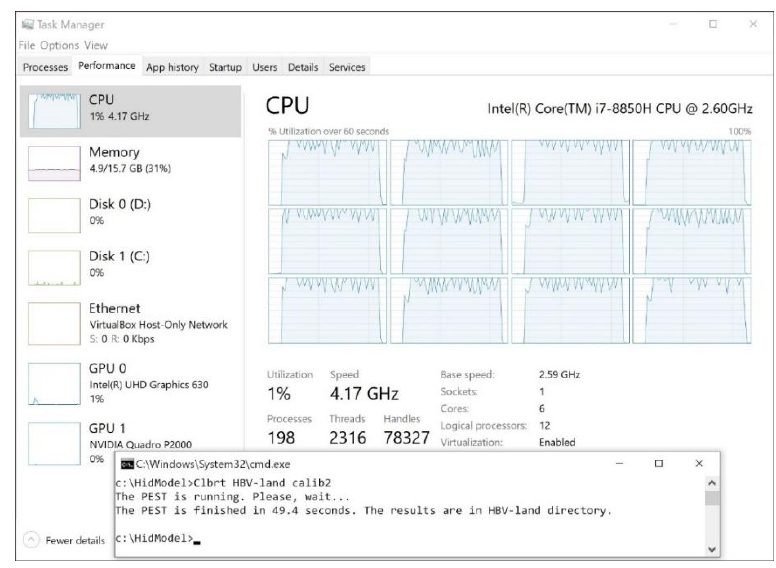
Figure 6. CPU utilization when HBV-Land is calibrated with parallel PEST.